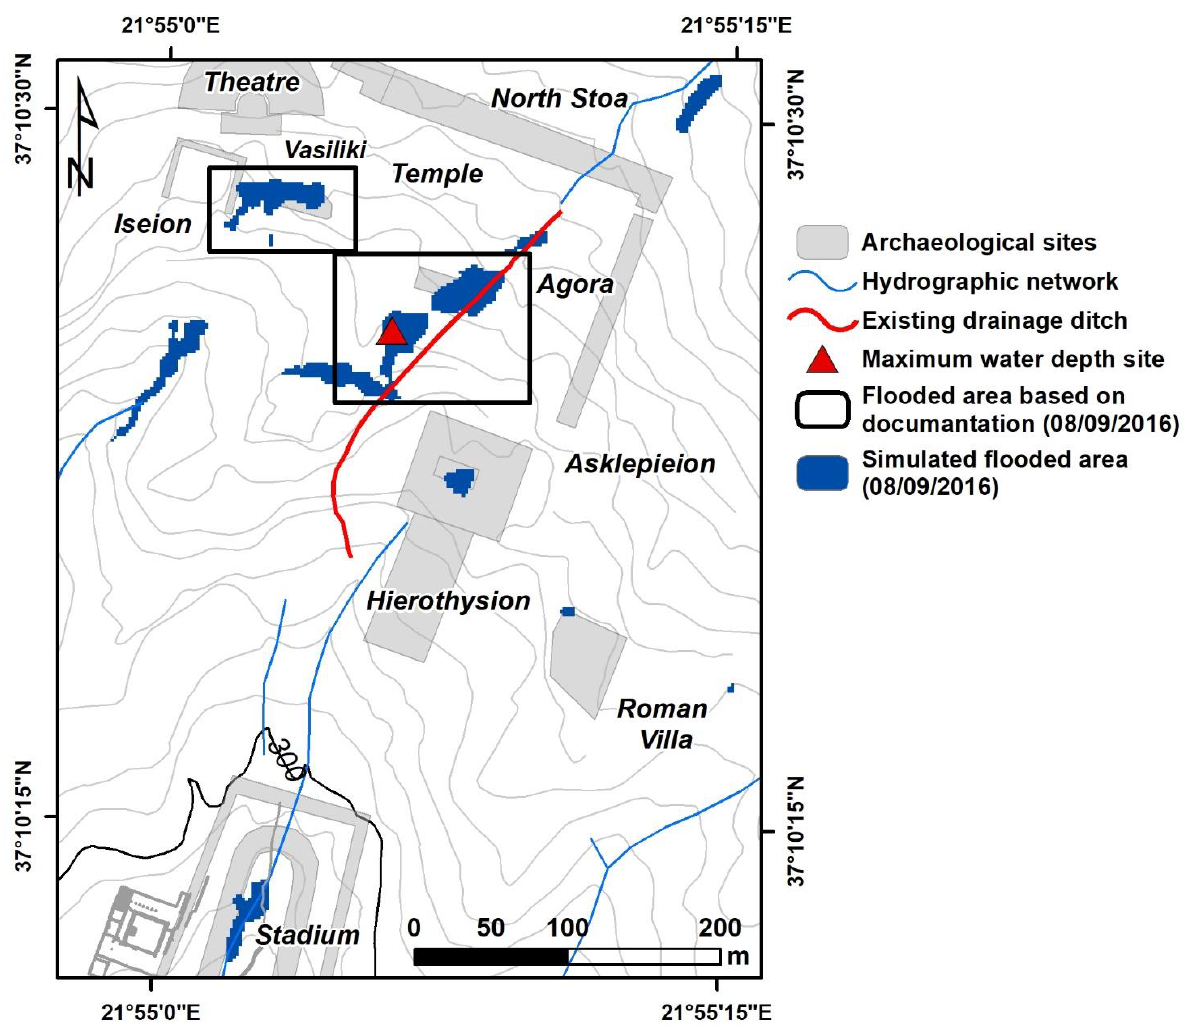
Figure 3. Documented and simulated inundated area of the Ancient Messene archeological site on 8 September 2016.